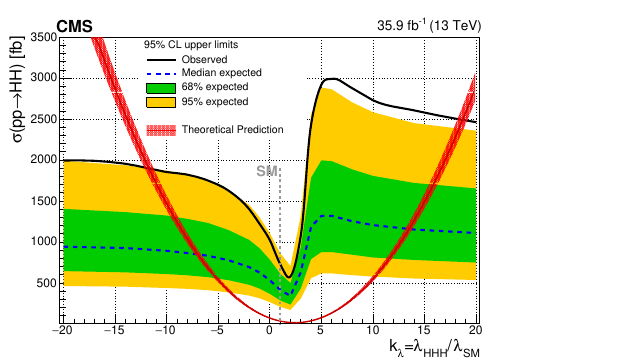
Figure 11 . Left: scan in κ λ based on full event-by-event shape interpolation from the CMS analysis [48]. Right: scans in κ λ / 10 , κ t , c 2 , using the CMS limits on benchmarks from the same analysis. Excluded regions at 95% CL correspond to dashed lines. Note that κ λ is divided by 10 to appear on the same scale as the other parameters.